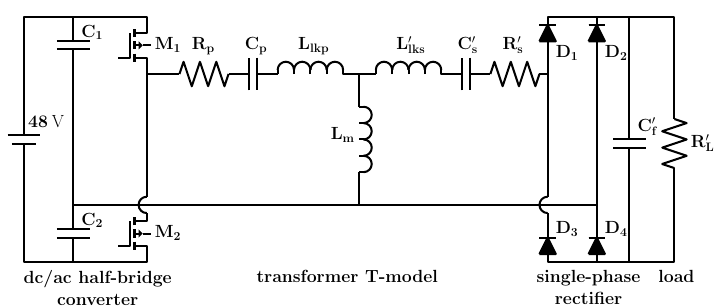
Figure 3. Electrical equivalent circuit model including series–series resonant capacitors and indication of the various